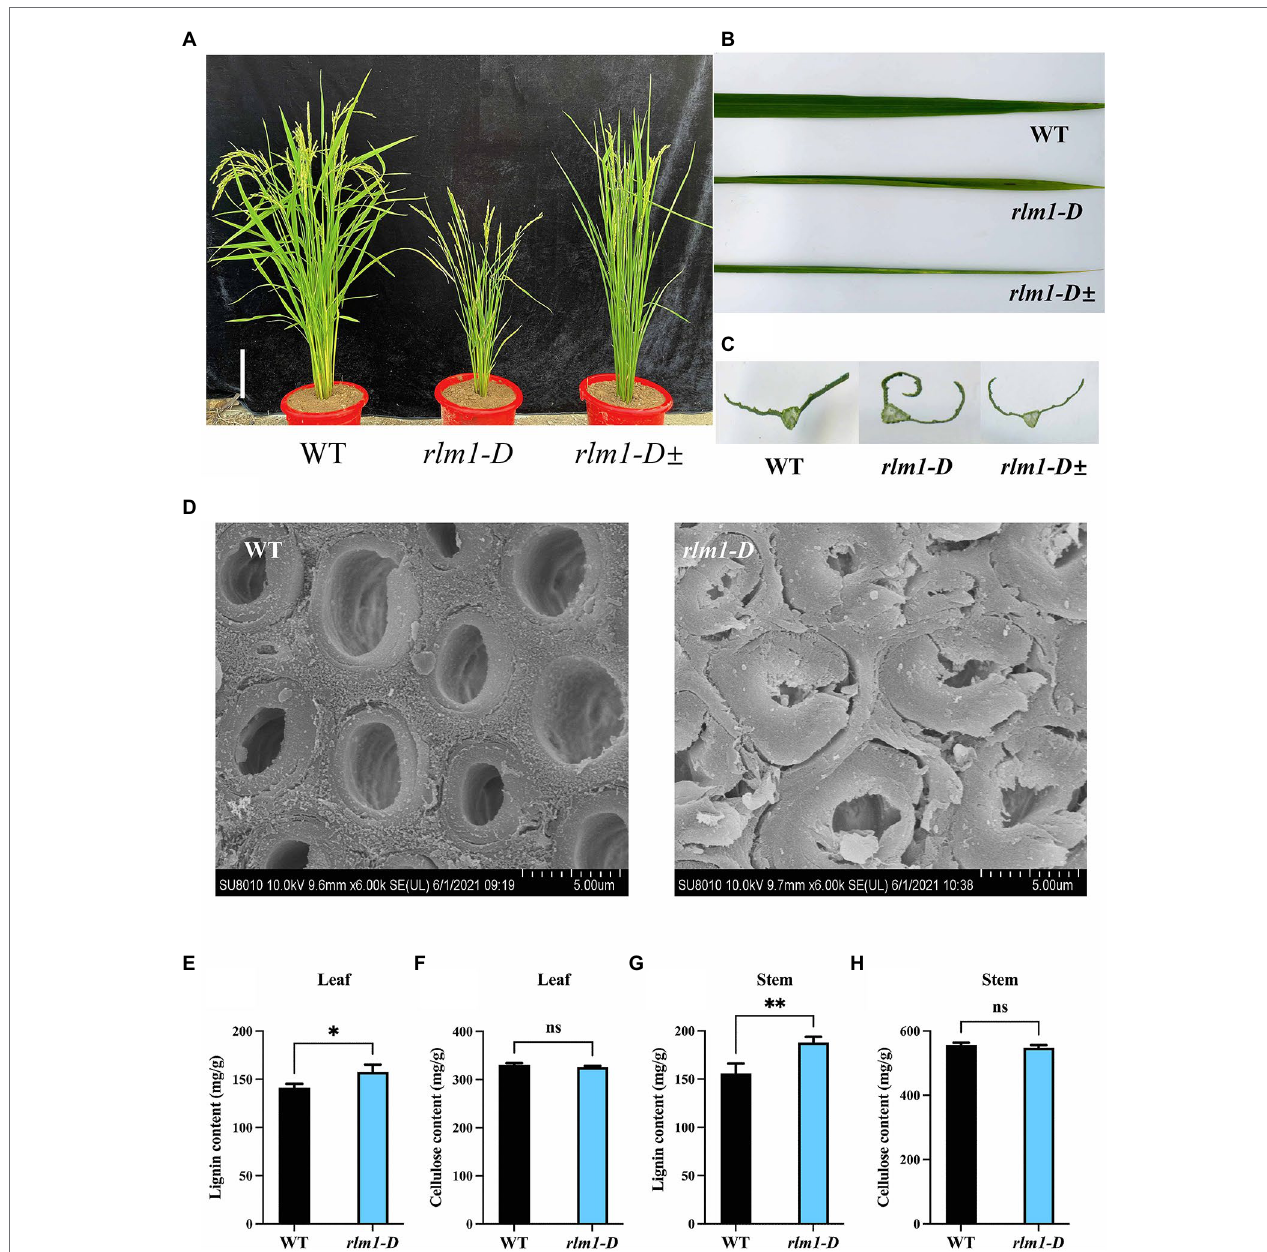
FIGURE 2 | Clarification of the rlm1-D phenotype. (A) Phenotype comparisons of WT, rlm1-D , and rlm1 heterozygous ( rlm1-D ±) plants at the heading stage. Bar = 5 cm. (B) Flag leaf comparison of the plants shown (A) . (C) Flag leaf cross-section comparisons of the plants shown in (A) . (D) SEM observations of sclerenchyma cell walls in the internodes from the 3-month-old WT and rlm1-D plants. Bar = 5 μ m. (E) Lignin content measurements in WT and rlm1-D leaf tissue. (F) Cellulose content measurements in WT and rlm1-D leaf tissue. (G) Lignin content measurements in the internodes of the 3-month-old WT and rlm1-D plants. (H) Cellulose content measurements in secondary stem tissues of WT and rlm1-D plants. * p < 0.05, ** p < 0.01 (Student’s t